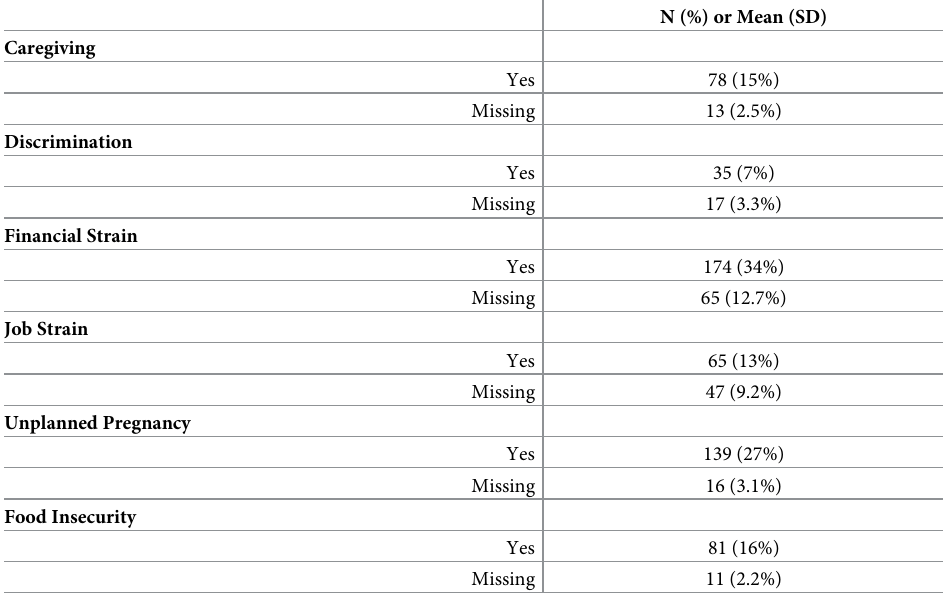
a Higher scores for Perceived Stress, Depression, and Neighborhood Quality indicate higher stressor and response levels. Lower scores for Community Status indicate higher stress response